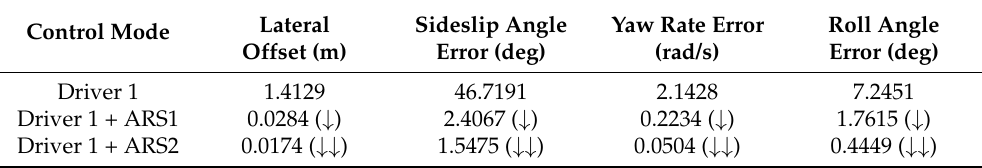
Table 5. Maximum control errors of active safety performances in Case